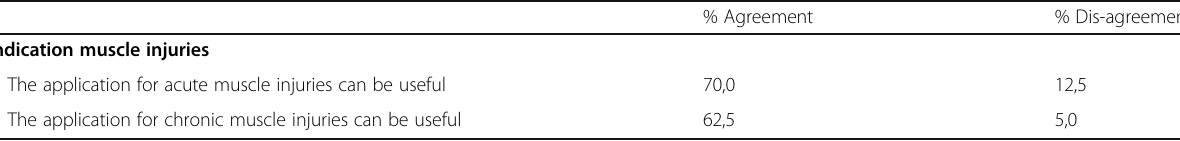
Table 3 Indication for use of PRP for muscle injuries